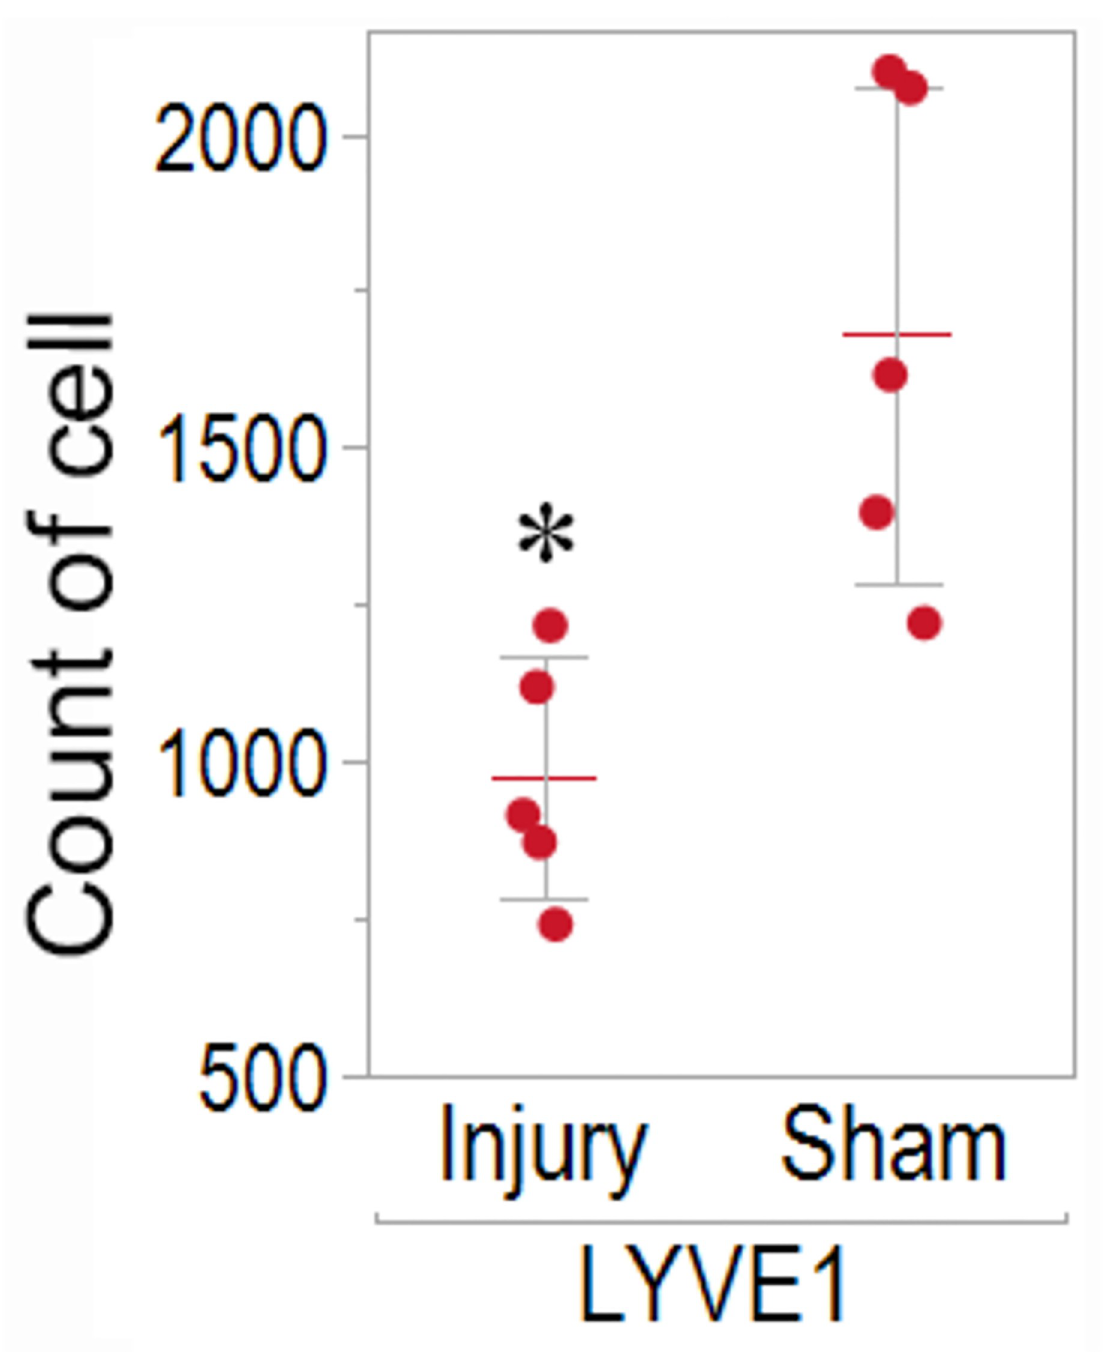
Fig 3. Count of viable LYVE1 positive meningeal lymphatic endothelial cells (LECs) via flow cytometry. The count of viable, CD45-CD31+PDPN+, LYVE1-positive meningeal LECs was compared between the injury and sham groups 3 days after injury via flow cytometry. ( � p = 0.0122 between the injury and sham groups, n = 5 for each group).